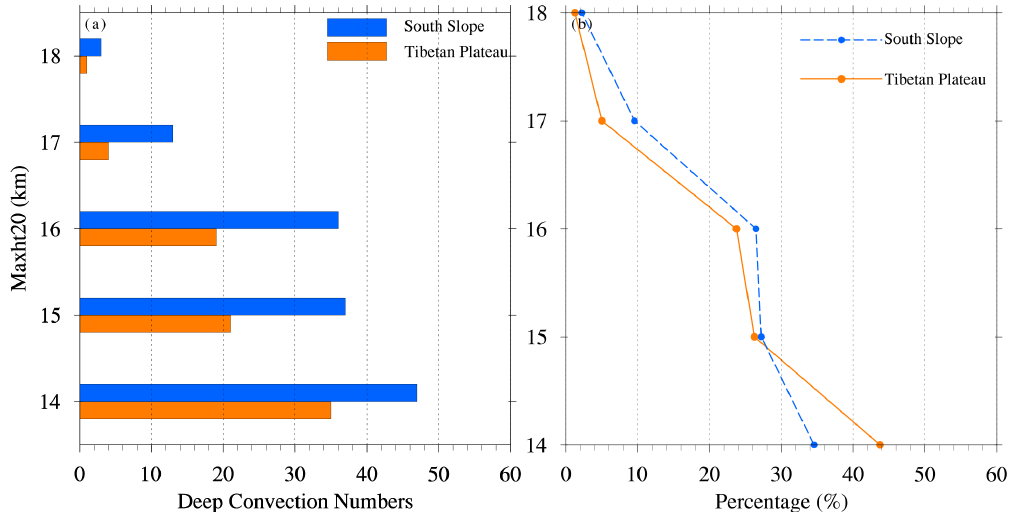
Figure 5. ( a ) The frequency and ( b ) the probability density function of DCSs varied with height of Maxht20. Warm and cold color describe the TP and SS region.